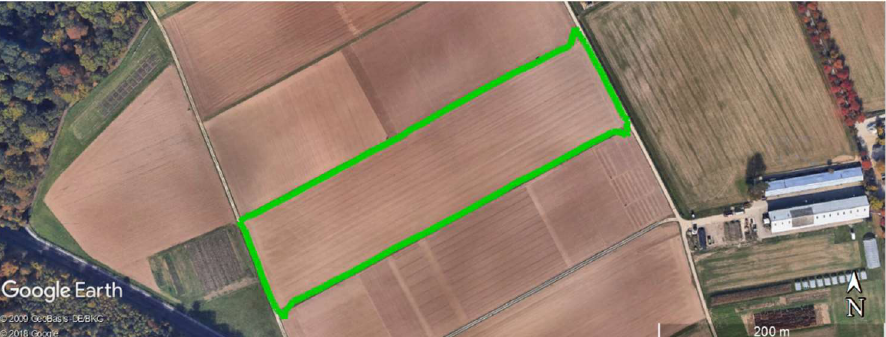
Figure 15. Satellite view of the examined field and the detected boundary (green line).